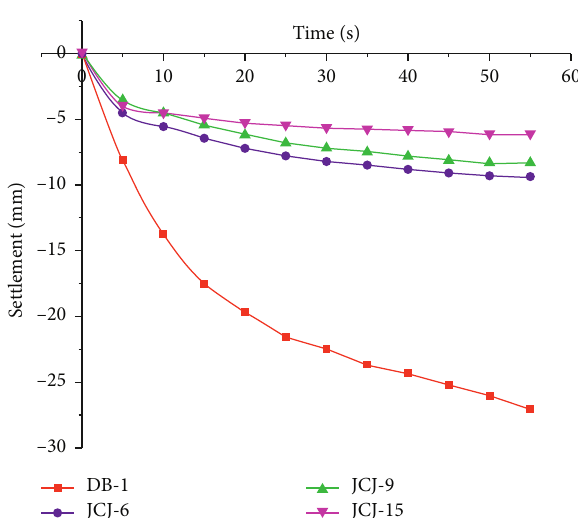
Figure 4: Settlement values of monitoring